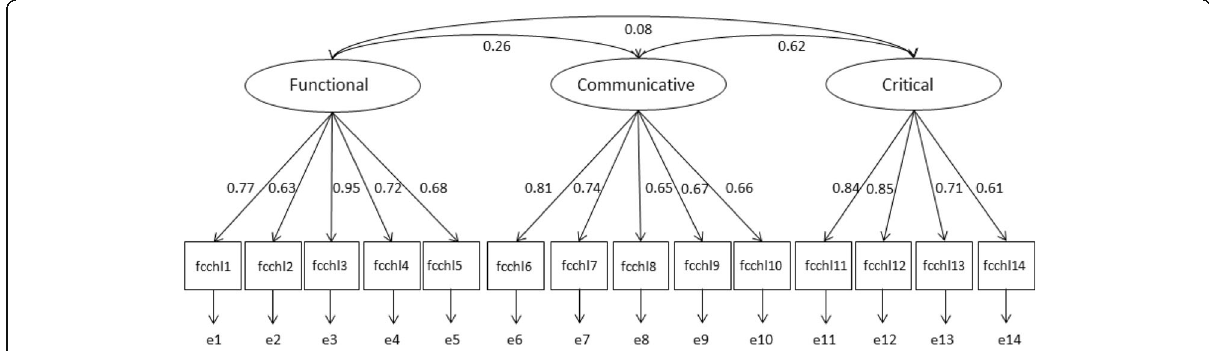
Fig. 1 Standardized parameter estimates for the 3-factor model of FCCHL ( n =1561, validation sample). Rectangles represent the observed variables (items) and ellipses represent the latent constructs (factors). Values on the single-headed arrows leading from the factors to the items are standardized factor loadings. Values on the curved double-headed arrows are correlations between factors